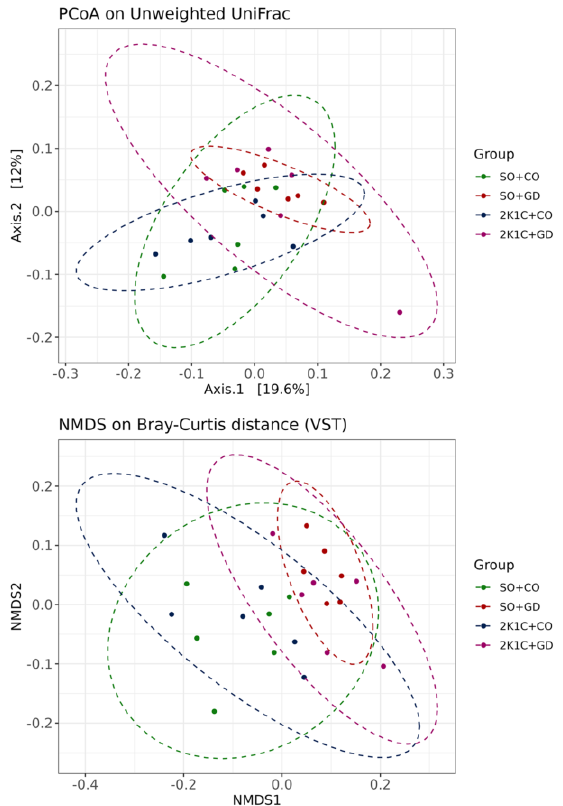
Figure 5. Beta-diversity plots. Two-dimensional PCoA on unweighted Unifrac distances and NMDS based on Bray – Curtis dissimilarity were generated.